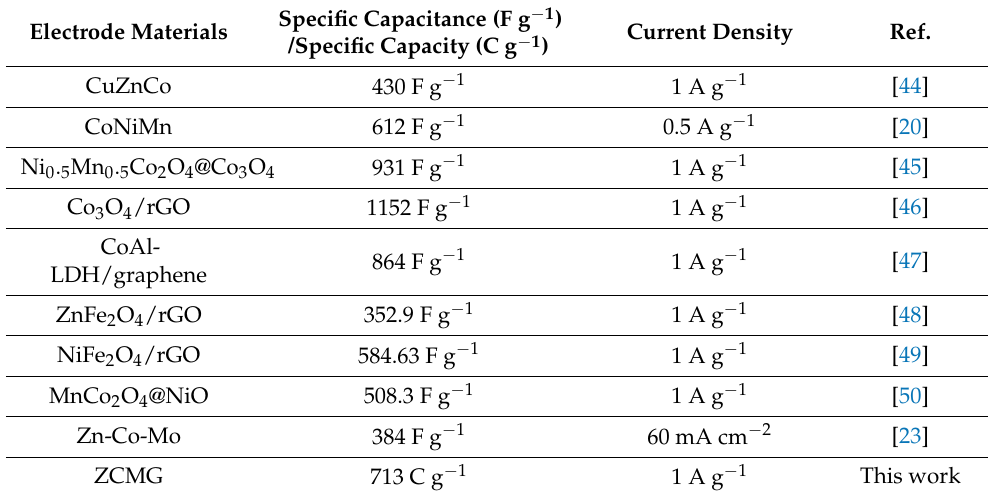
Table 1. Comparison of relevant electrode materials reported in recent